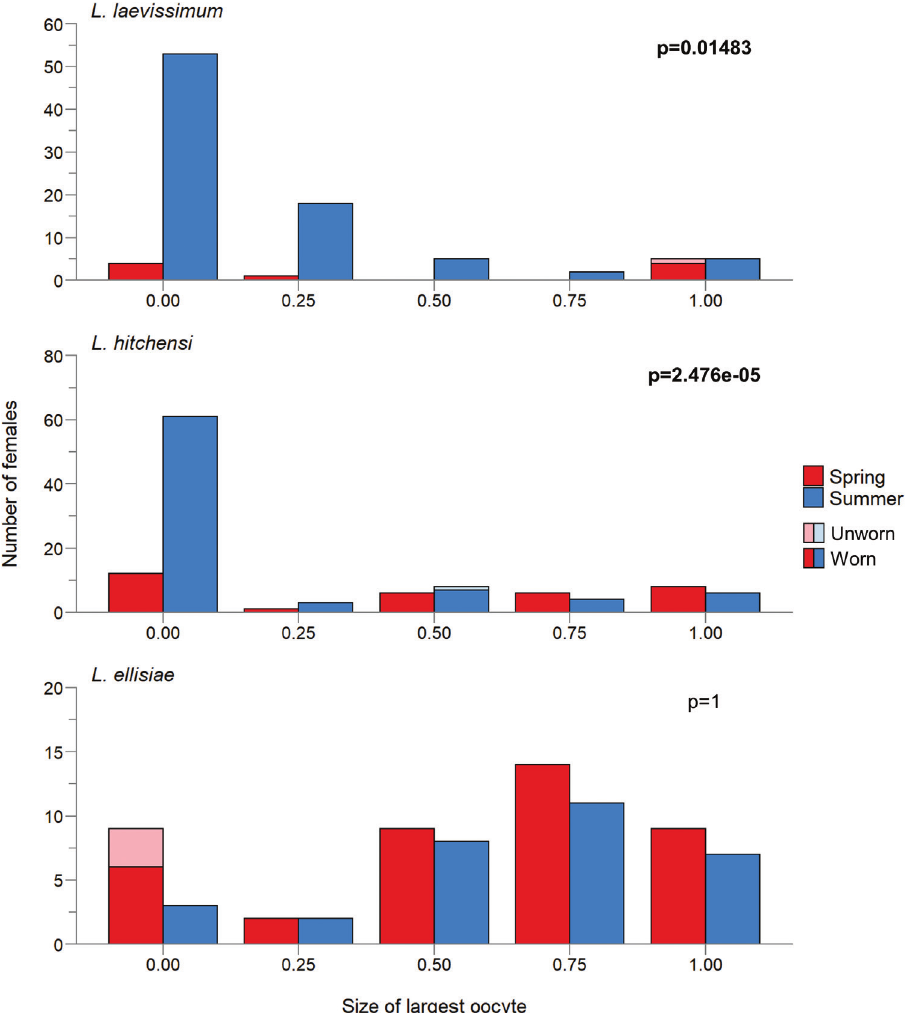
Figure 2. Wear and ovarian development of adult females caught in spring and summer. Fisher exact tests were used to compare the proportions of spring and summer females in each ovarian category. Unworn summer females with no ovarian development were excluded, as these females likely were newly eclosed. In L. laevissimum and L. hitchensi , spring females were significantly more likely to be fecund (largest oocyte at least 1/2-developed), while in L. ellisiae , spring and summer females showed similar levels of ovarian development (see Table 3 for